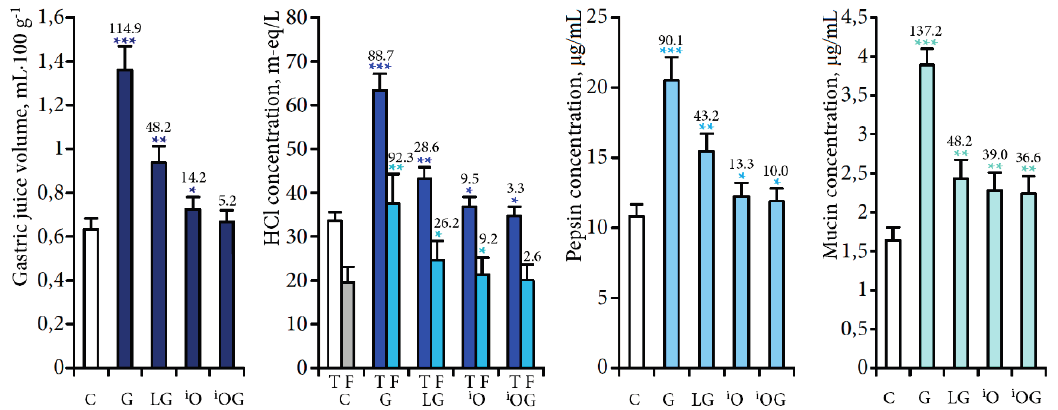
Figure 5. Influence of decoctions of four gentian herbs and individual compounds on gastric juice parameters in rats. Under bars: percentage difference compared to the control. Values shown are mean ± SD ( n = 10–12). Asterisks indicate statistically significant values from control (* p < 0.05; ** p < 0.01; *** p < 0.001). C—control, G.a. — G. algida , G.d. — G. decumbens